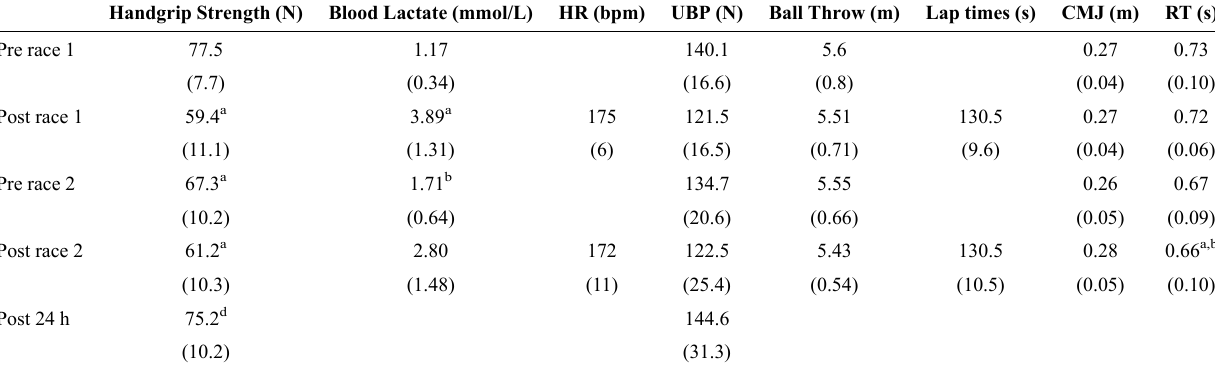
Table 1 - Test results before (Pre) and after (Post) two motorcycle races separated by a passive recovery protocol. Data are shown as mean (standard deviation). Handgrip Strength